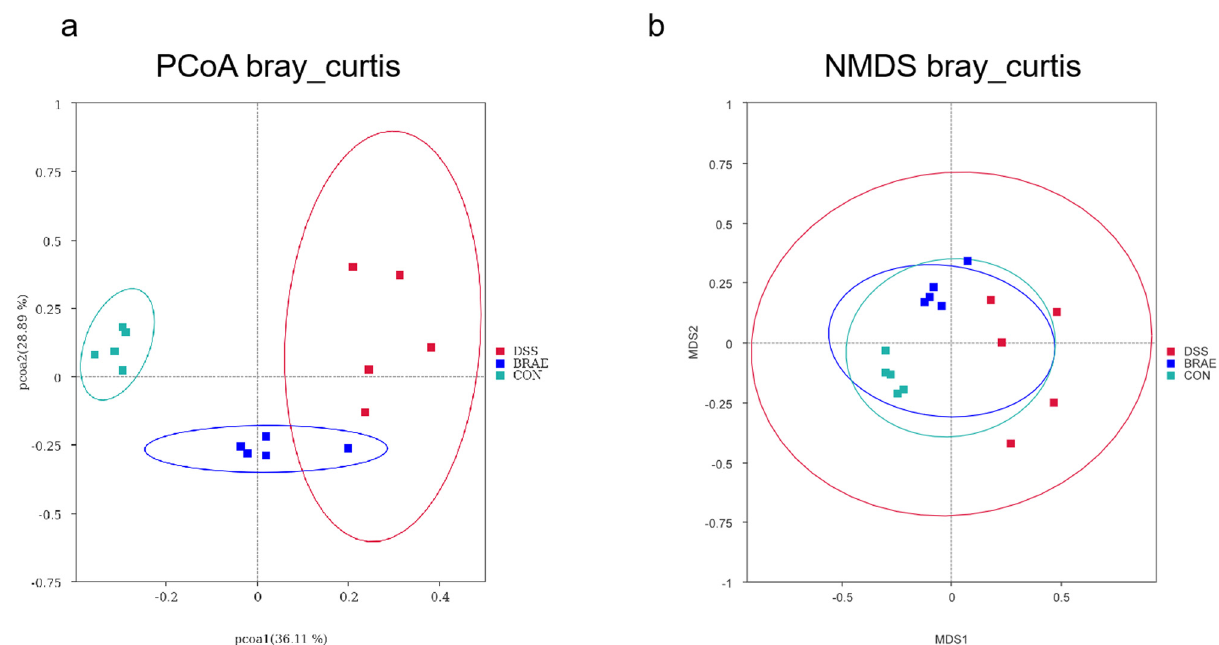
Figure 9: Beta diversity inter - group matrix. ( a ) PCoA bray_curtis and ( b ) NMDS